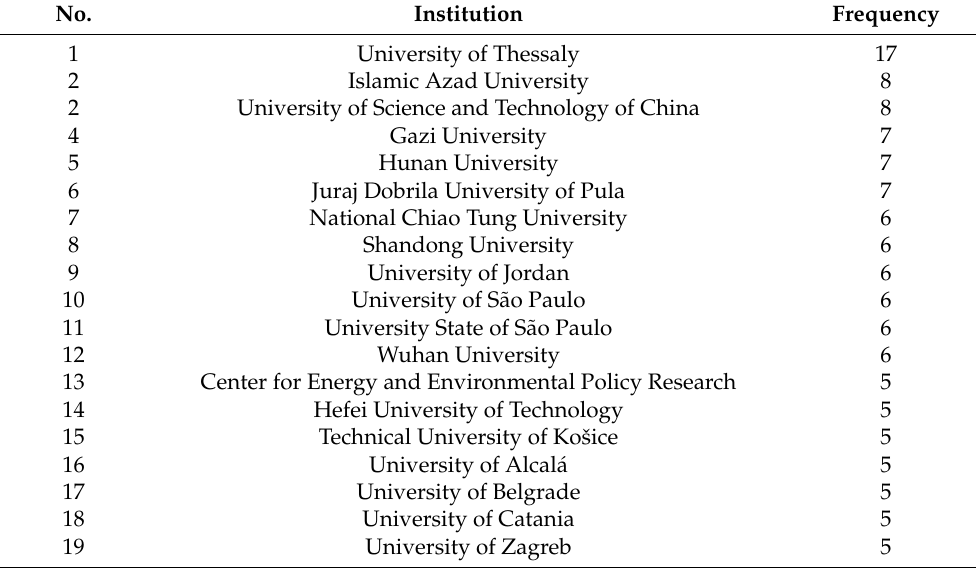
Table 19. List of the top 19 institutions that authors were affiliated with.